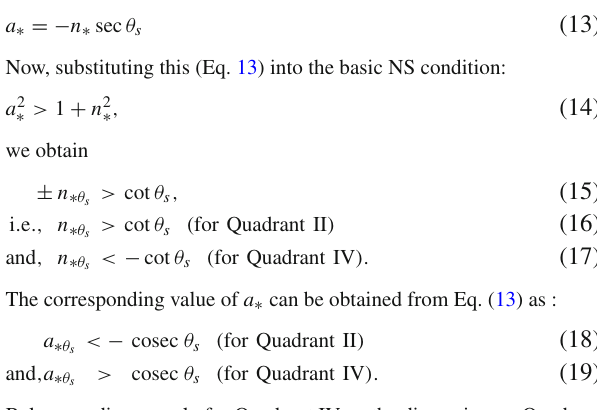
Fig. 3 will be shifted towards the right side of the plot for n ∗ (cid:2) − 3 .